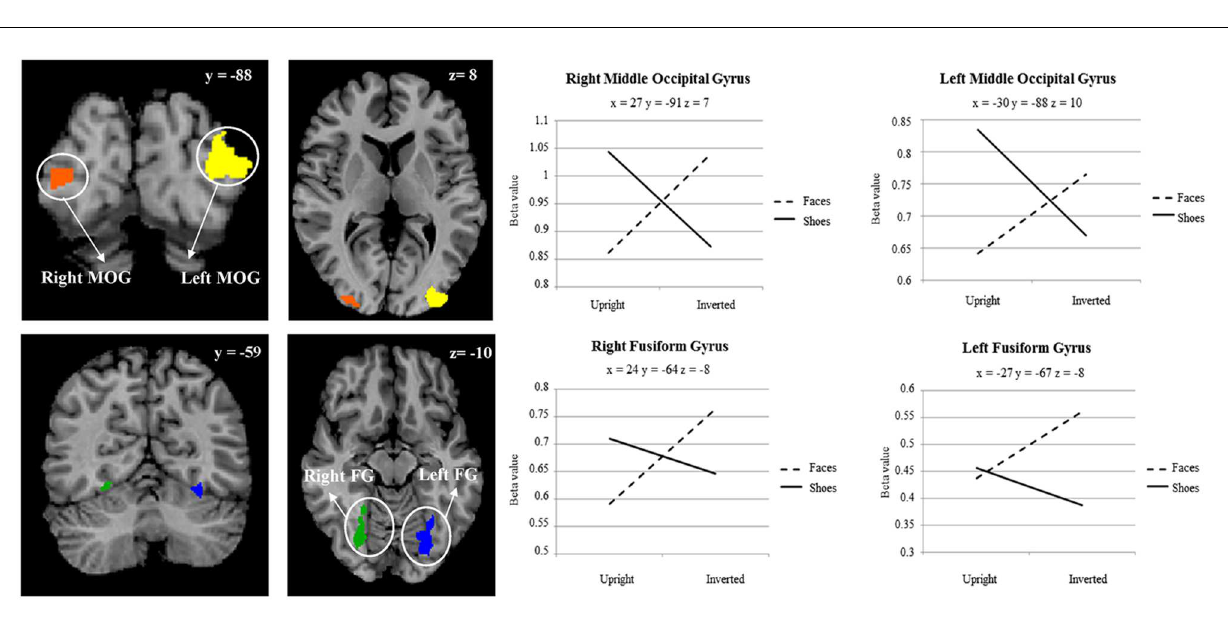
FIGURE 2 | Two-way interaction between category of stimulus, and stimulus orientation, within a whole brain search. Plot shows average beta value within cluster for each point measured. Coordinates are in Talairach